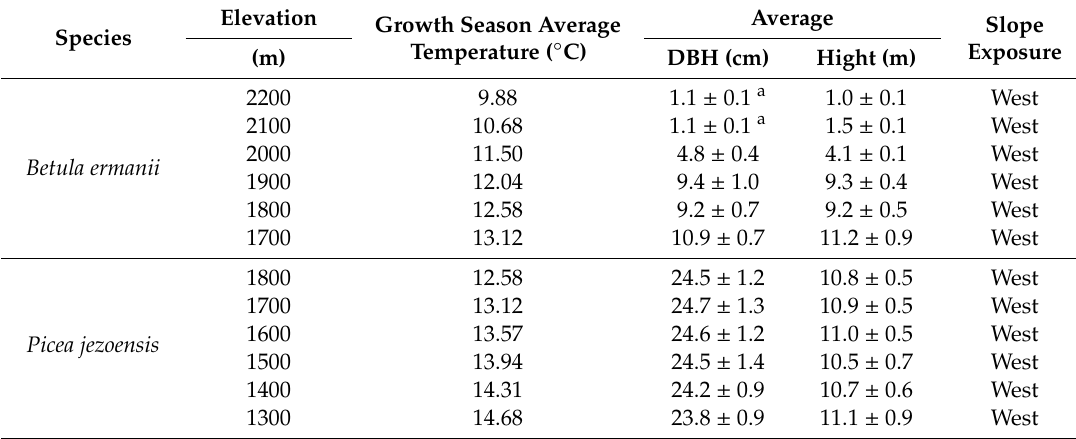
Table 2. Characteristics of the plots and the sampling trees Betula ermanii (mean ± standard